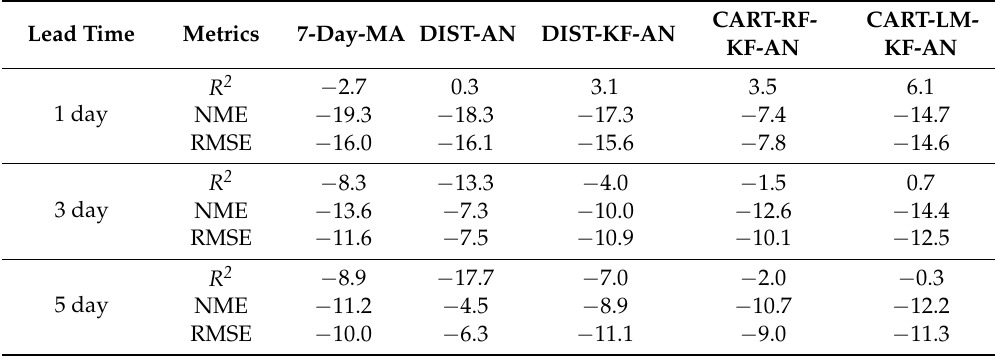
Table 2. Percentage changes (%) of the performance statistics with respect to original model forecast by the five methods in the “correction estimation”